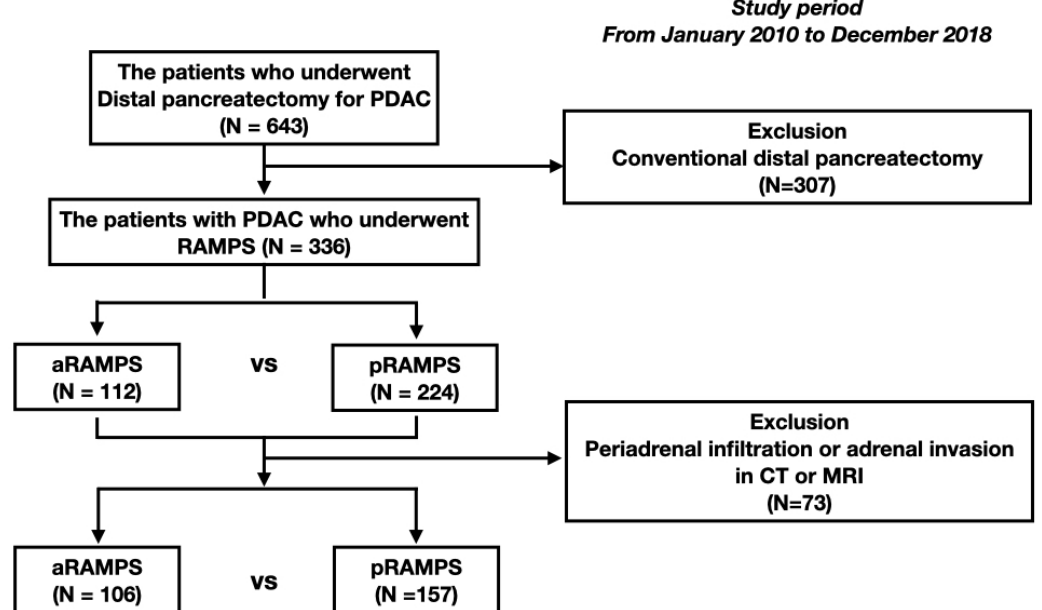
Figure 1. Study patient flow diagram. A retrospective review was conducted of 336 patients who underwent a distal pancreatectomy. Of these cases, 112 patients underwent aRAMPS and 224 patients underwent pRAMPS. After excluding patients with periadrenal infiltration or adrenal invasion evident on preoperative computed tomography or magnetic resonance imaging, 106 aRAMPS patients and 157 pRAMPS patients were compared.